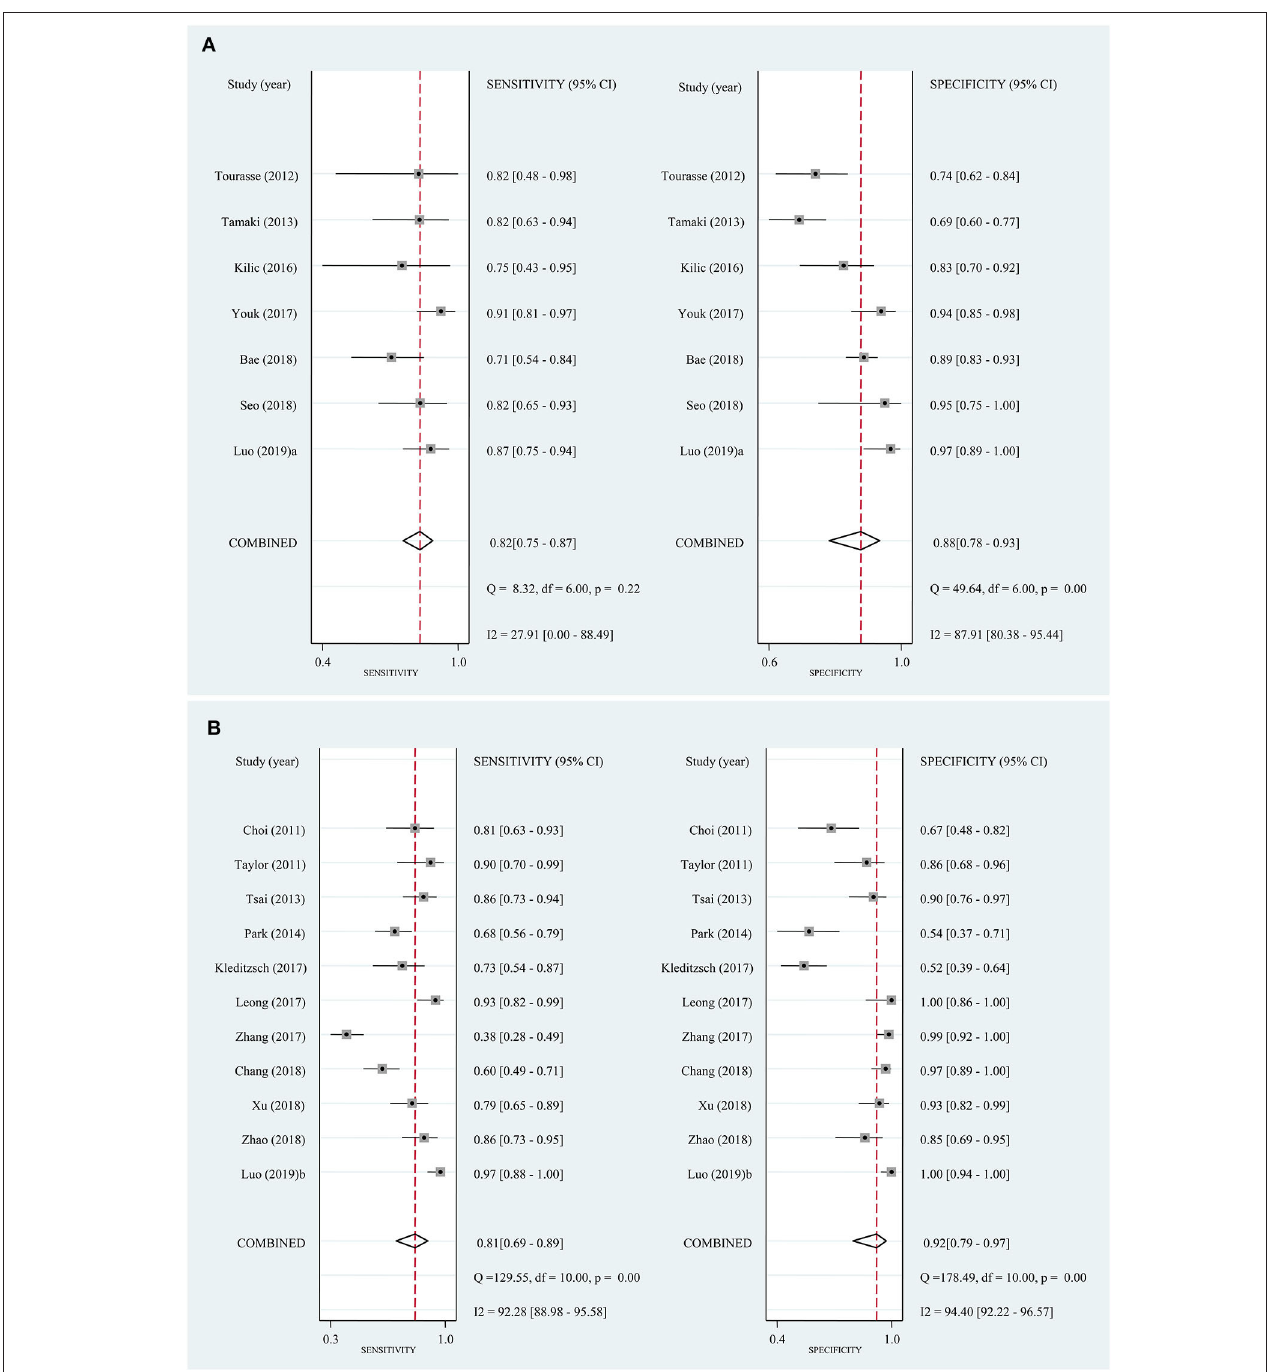
FIGURE 2 | Forest plots of sensitivity and specificity for the included studies. Bivariate mixed-effects regression model was used to calculate the pooled sensitivity and specificity. (A) Quantitative elastography studies; (B) qualitative elastography studies. CI, confidence interval.